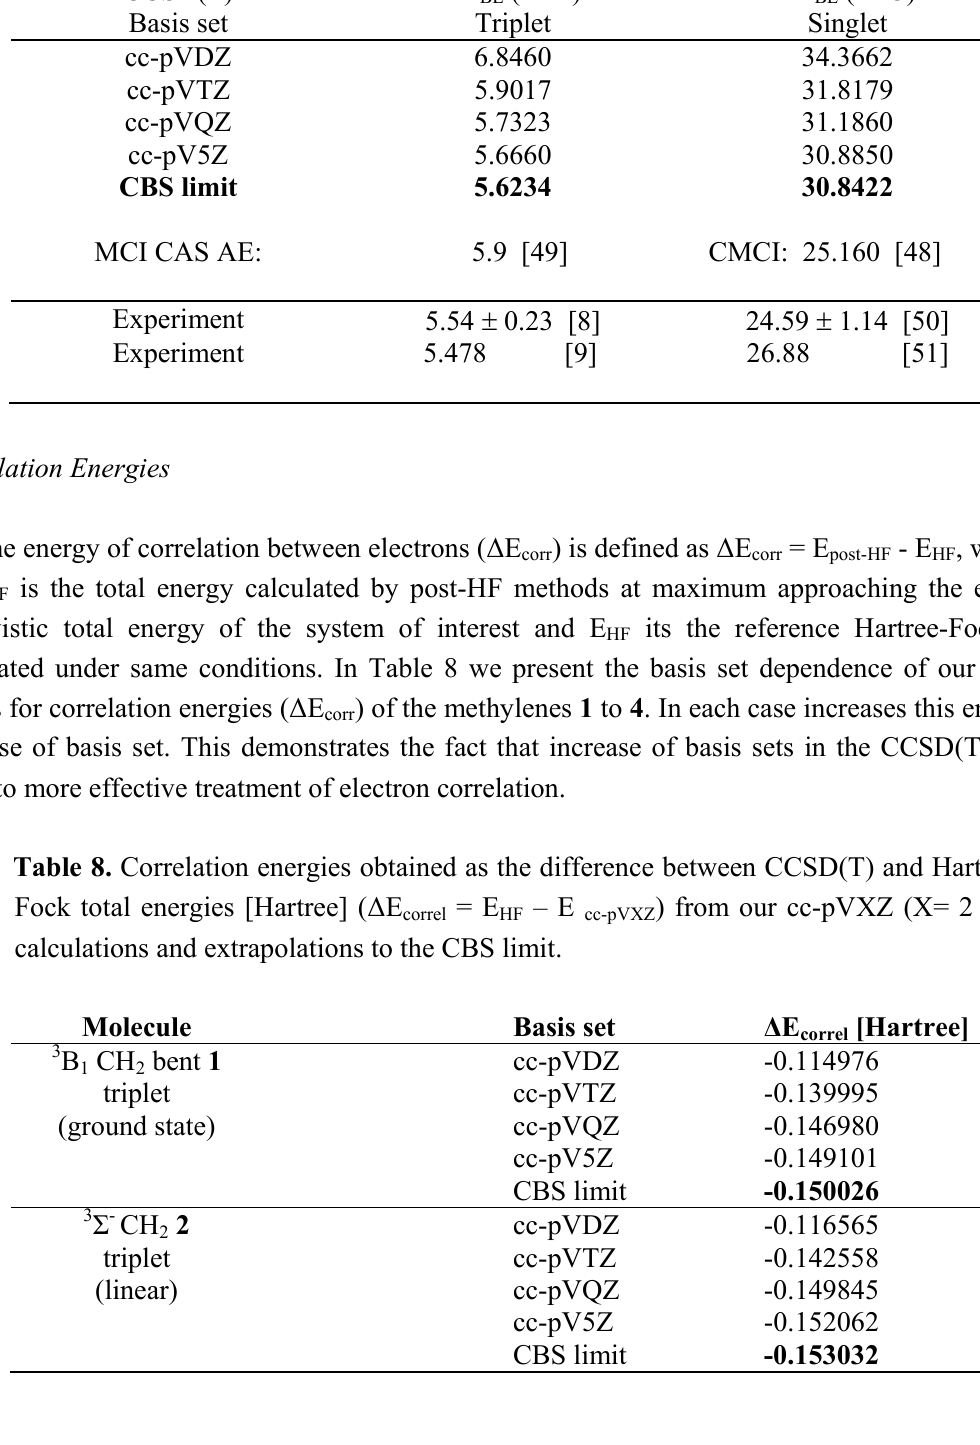
[kcal/mol] of triplet CH BL